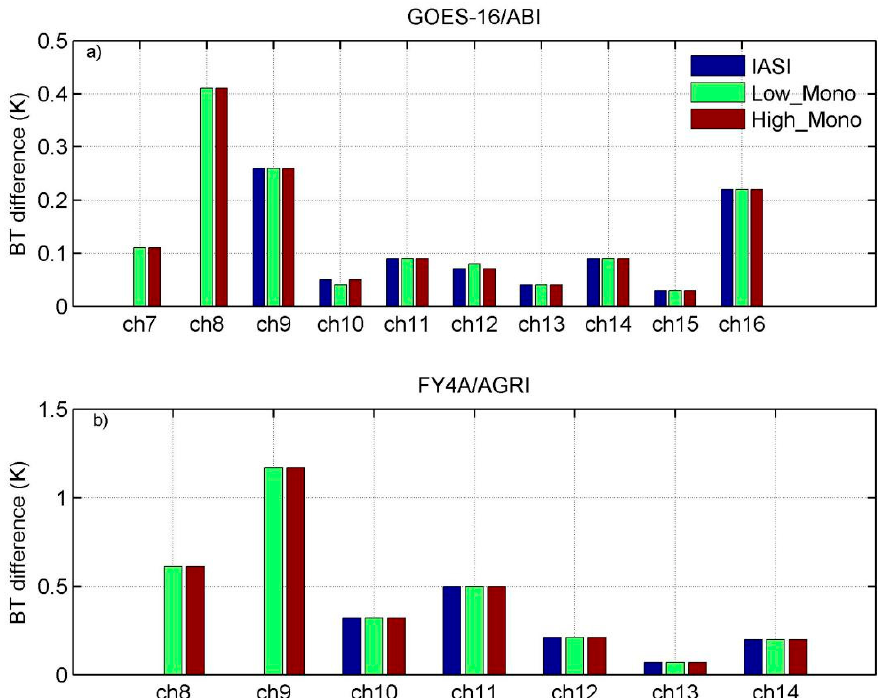
Figure 5. Mean value of SCDs calculated from the six standard atmospheric profiles with respect to the radiance spectrum with three different resolutions (0.25 cm − 1 , 0.1 cm − 1 , and 0.001 cm − 1 ) for ( a ) ABI and ( b ) AGRI IR bands.